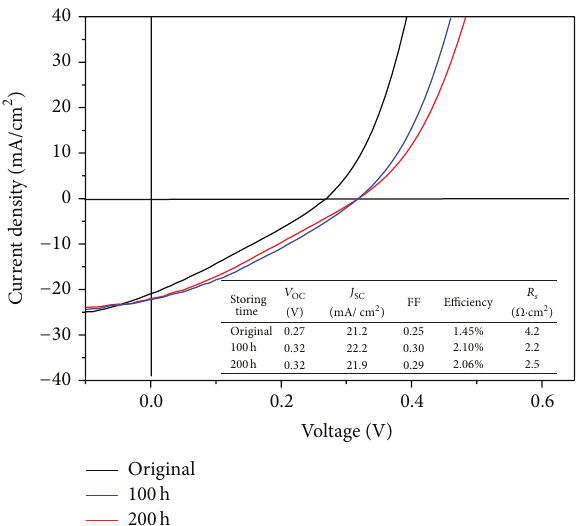
Figure 6: The evolution of the photovoltaic performance of the Gr-Si solar cell with exposing time after thermal annealing process.